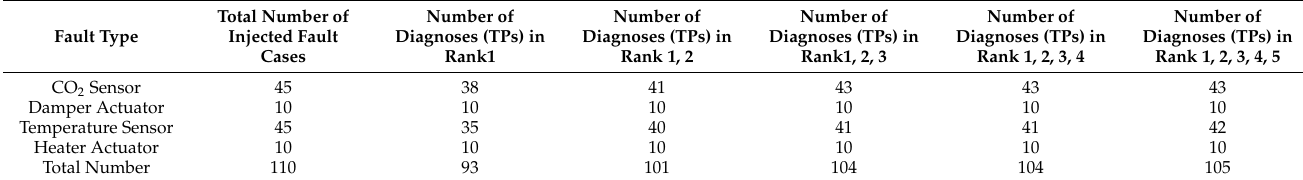
Table 24. Number of diagnoses in different cumulative ranks for different fault types.